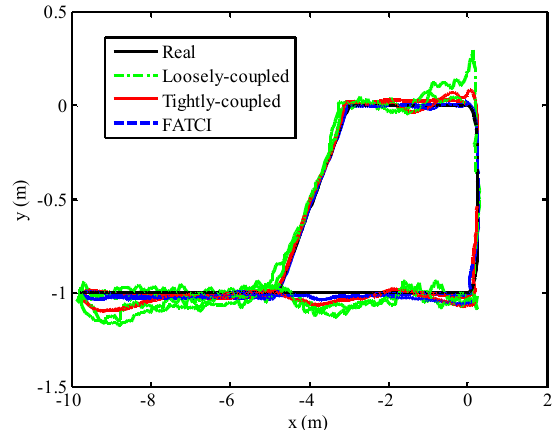
Figure 16. Positioning performance with different integrated methods based on WSN normal conditions.